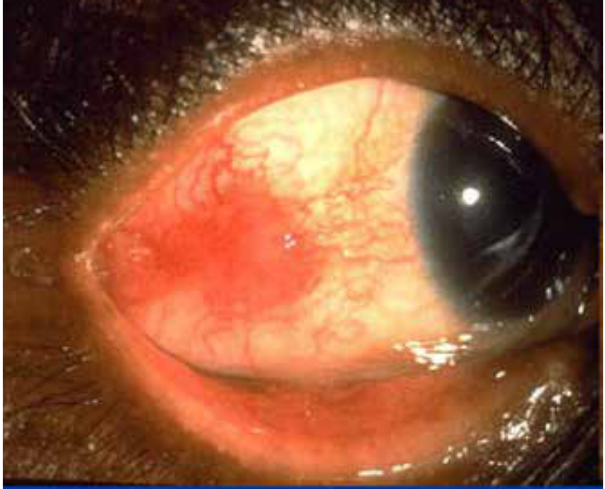
Figure 1: Clinical clue for MCQ